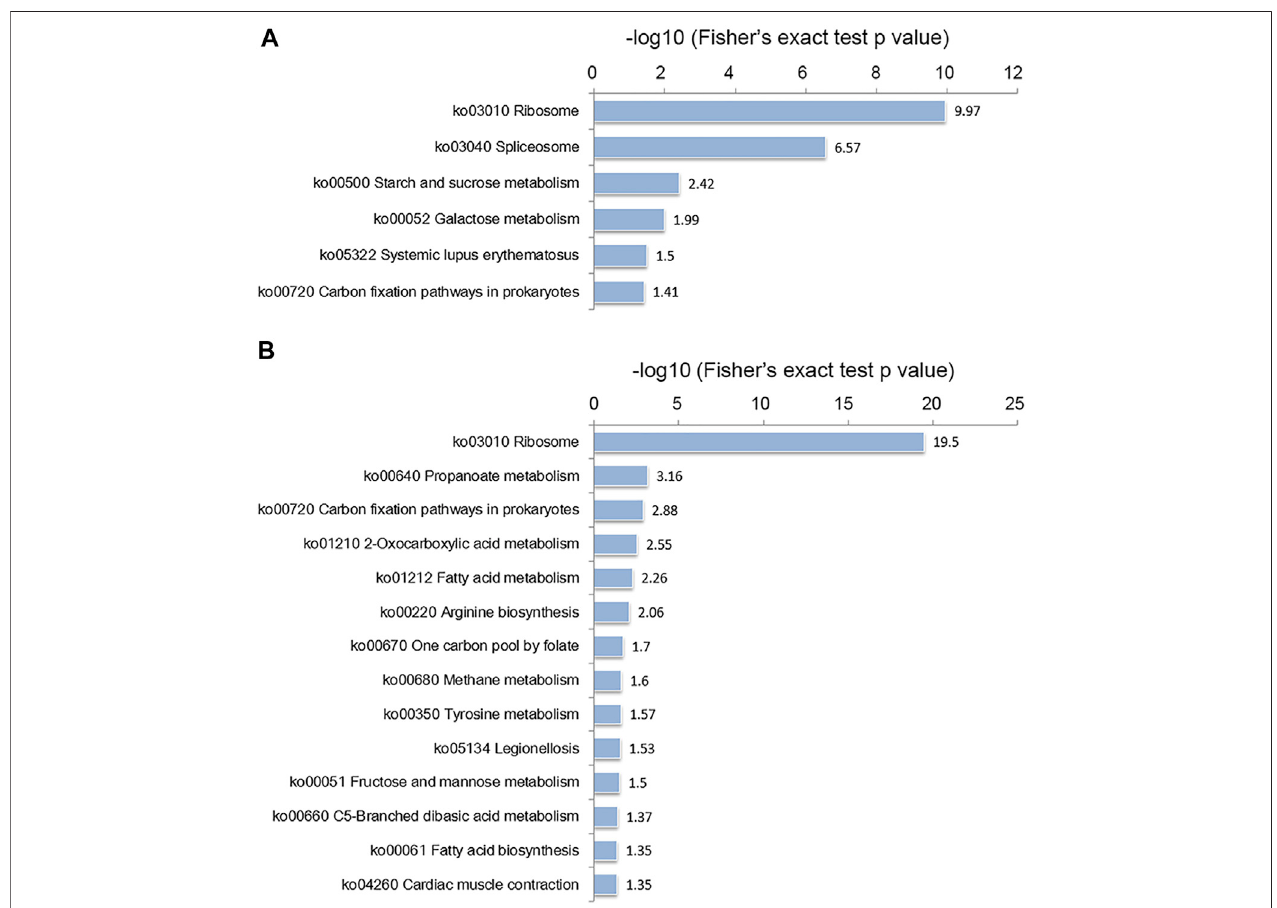
FIGURE 5 | KEGG enrichment analysis of crotonylated proteins in the (A) conidial stage and (B) mycelial stage.